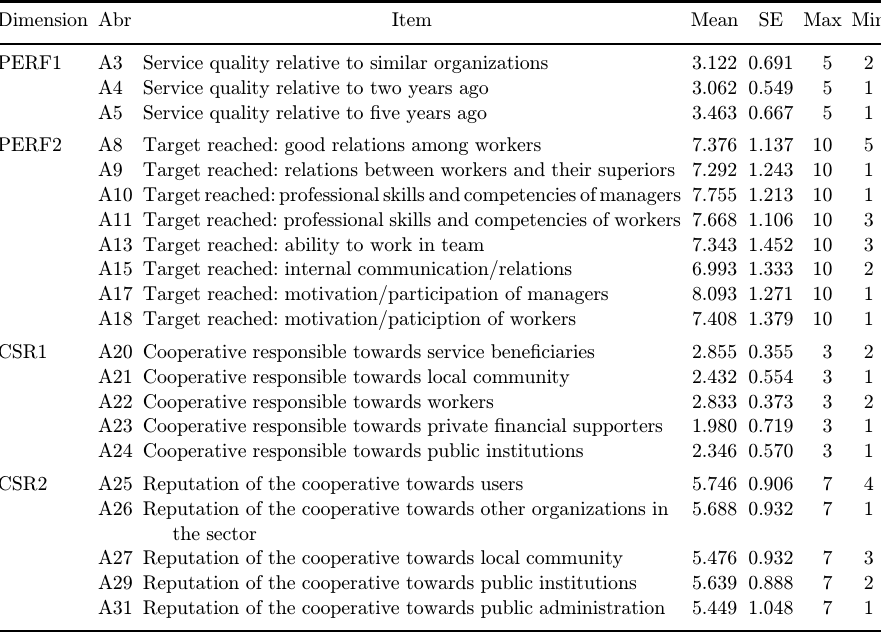
Table A.1. Descriptive